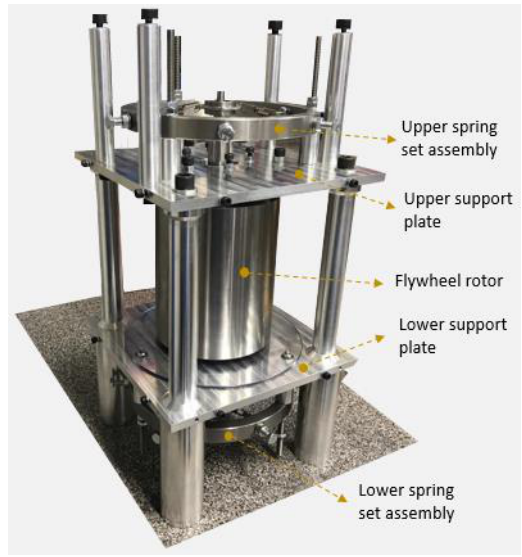
Figure 3. Configuration of the proposed flywheel.